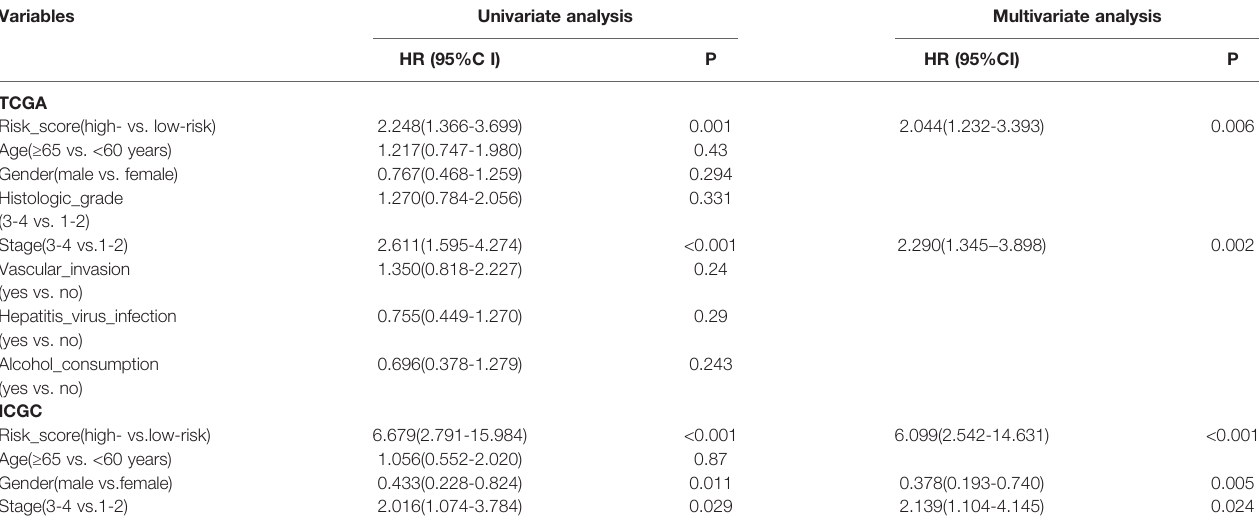
TABLE 3 | Univariate and multivariate Cox regression analysis of prognostic factors of hepatocellular carcinoma patients in TCGA and ICGC cohorts.